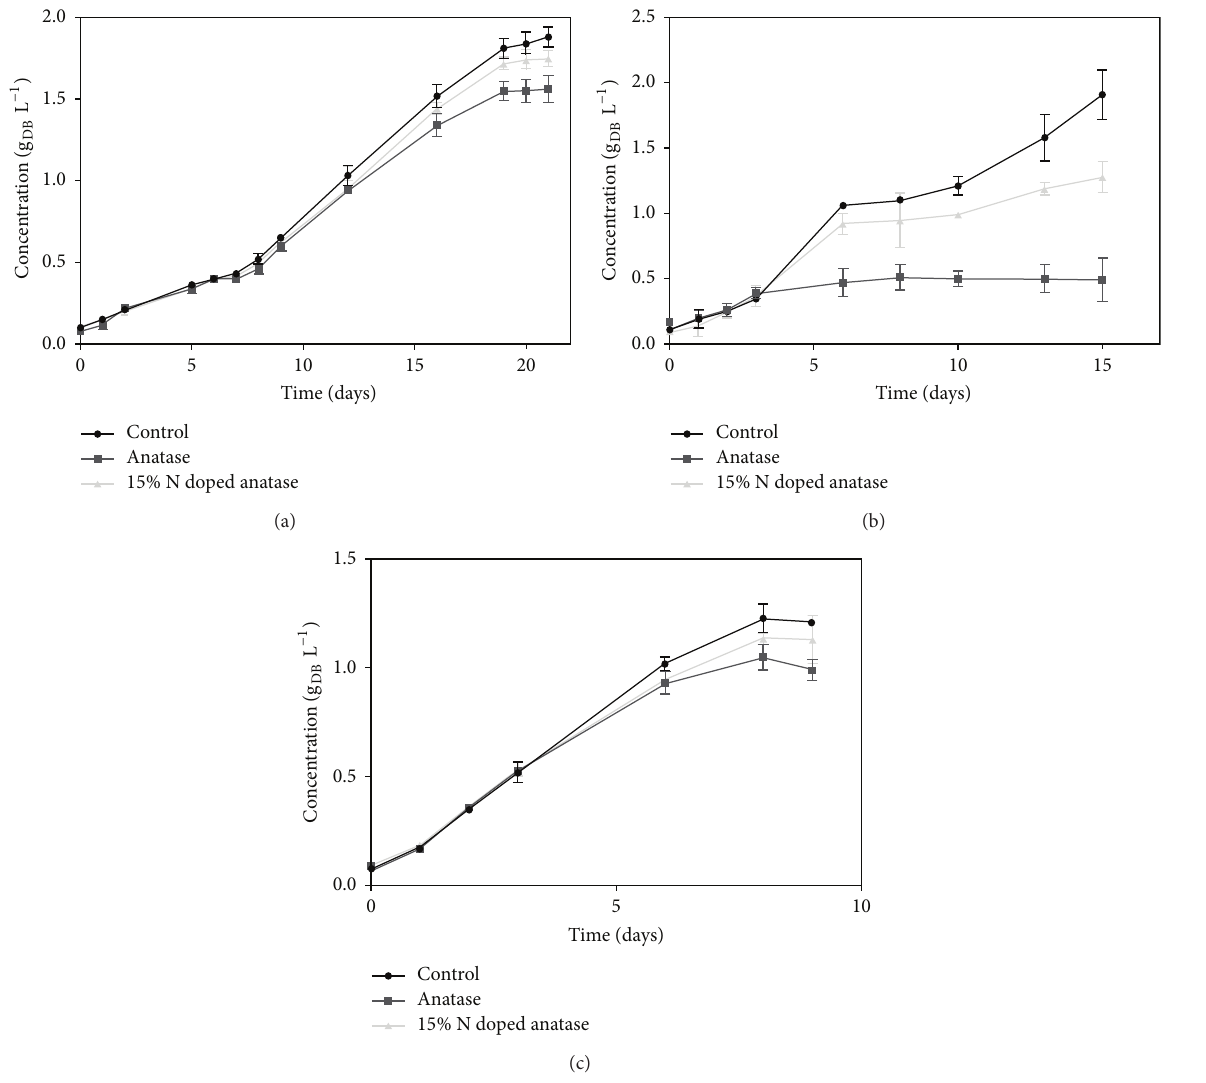
Figure 3: Effect of TiO 2 NPs on the growth of Chlorella vulgaris (a), Arthrospira platensis (b), and Haematococcus pluvialis (c). (g grams of dried biomass per litre of